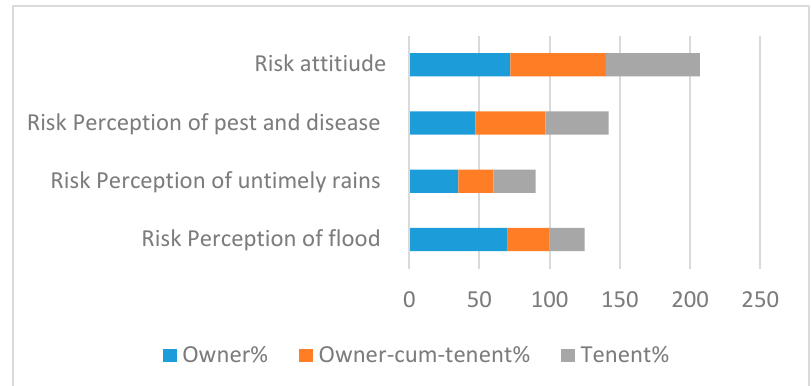
Figure 5. Risk perception and attitude by land tenancy.